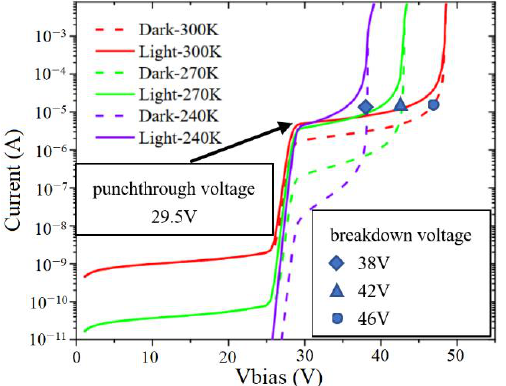
Figure 11. I-V characteristic curves at different temperatures.